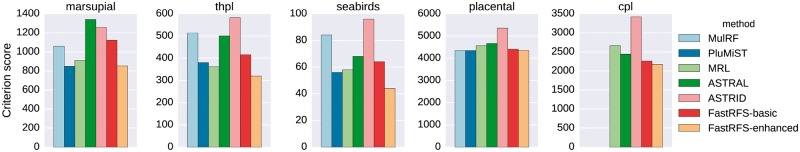
RFS criterion scores on biological data of supertree methods; lower is better. MulRF and PluMiST could not be run on the CPL dataset due to its large size; hence no values are shown for those methods on that dataset. Overall, FastRFS-enhanced produces the best RFS criterion scores on these datasets